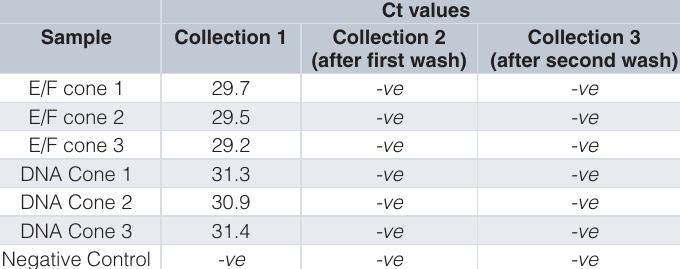
Table 3. Reusability of the superhydrophobic cone.